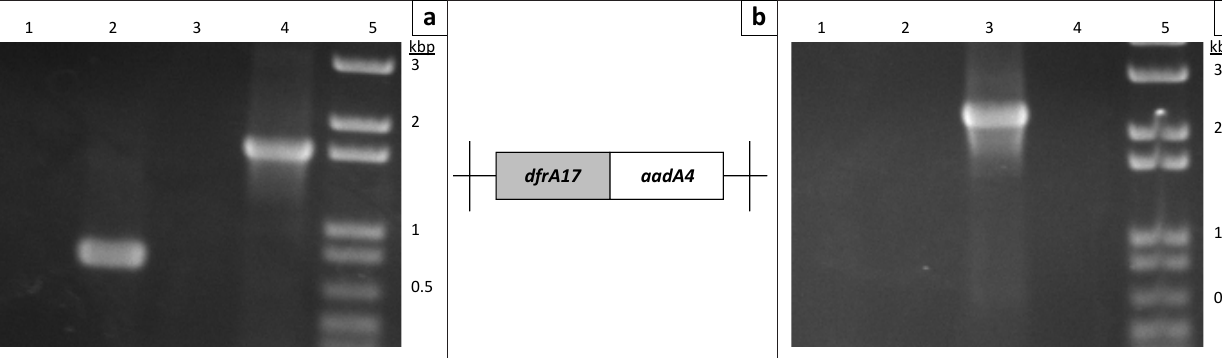
FIGURE 1: PCR amplification of the variable regions of class 1 and class 2 integrons. (a) Class 1 integron-variable regions amplified using Lev5’CS and Lev3’CS primers. Lane 1: No template; Lane 2: E. coli strain 042 bearing an aadA cassette within a class 1 integron; Lane 3: E. coli strain 17-2 bearing the dfrA1-sat-aadA cassette sequence within a class 2 integron; Lane 4: K. pneumoniae subsp. pneumoniae isolate K01 from this study; Lane 5: 1 kb Ladder plus (Invitrogen). Marker size fragments are indicated to the right of the gel in kilobase pairs. (b) Class 2 integron-variable regions amplified using hep51 and hep74 primers with samples shown in (a) loaded on to the gel. (c) Cassette content and orientation of the K01 integron amplified in (A), as predicted from the DNA